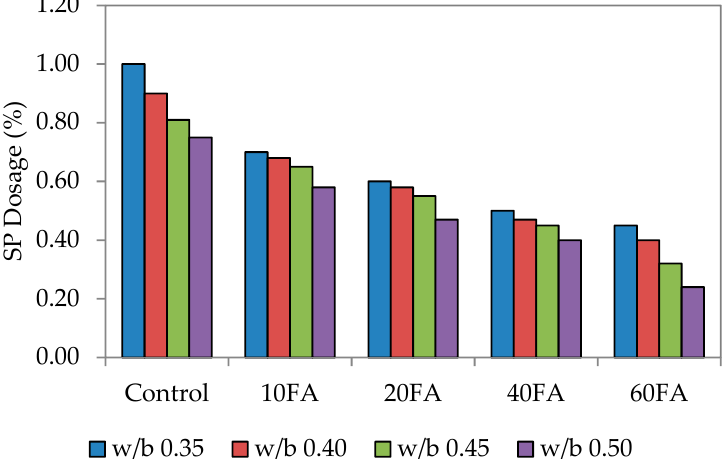
Figure 3. Superplasticizer dosage of high flowability.